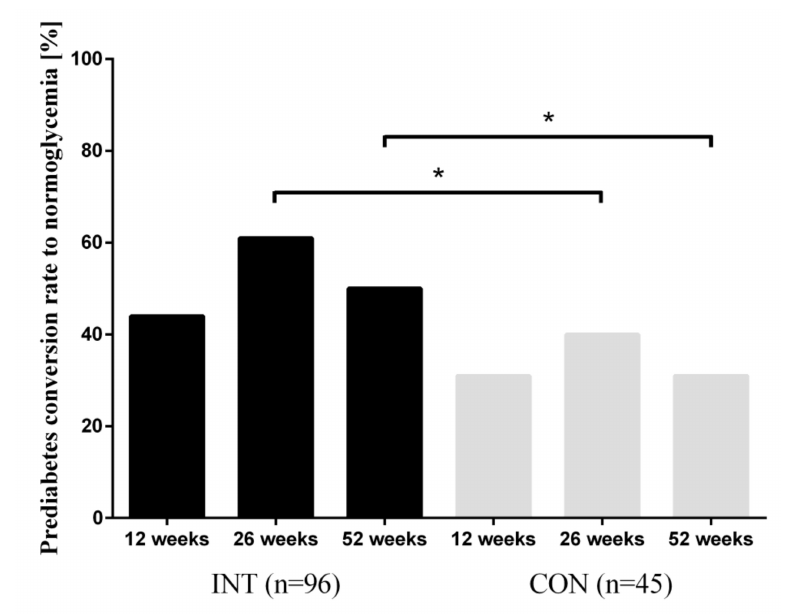
Figure 2. Prediabetes conversion rate to normoglycemia. HbA1c was determined at each follow-up and prediabetes was defined as HbA1c 5.7% to 6.5%. Data are presented as percentages. Analysis of di ff erences in frequency distribution of prediabetes conversion to normoglycemia was calculated using Fisher’s exact test; * p <